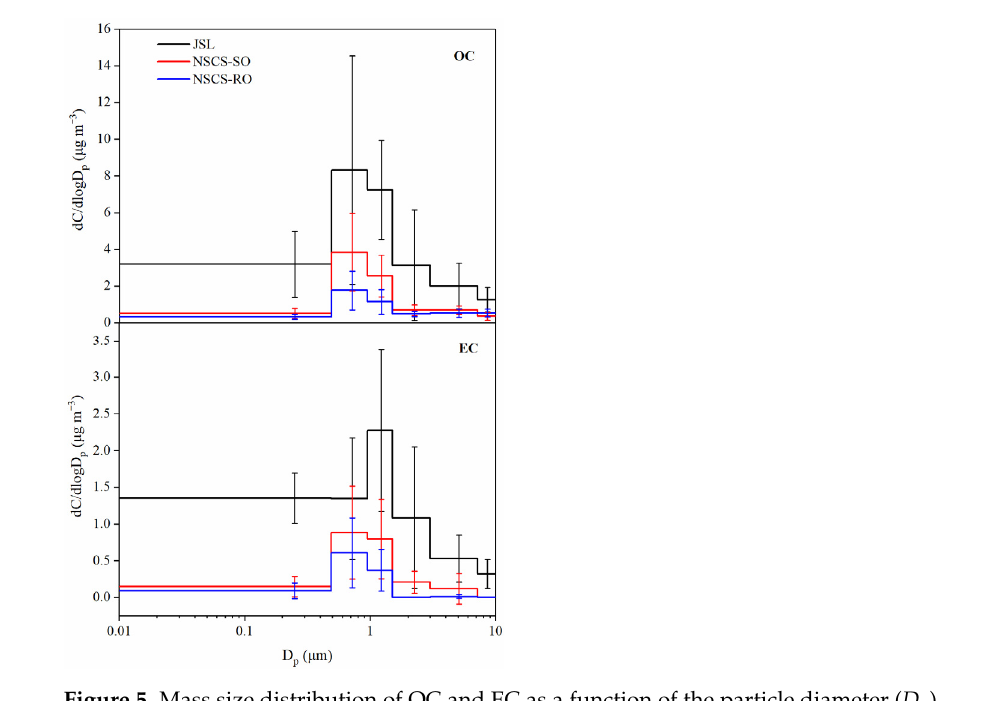
Figure 5. Mass size distribution of OC and EC as a function of the particle diameter ( D p ).